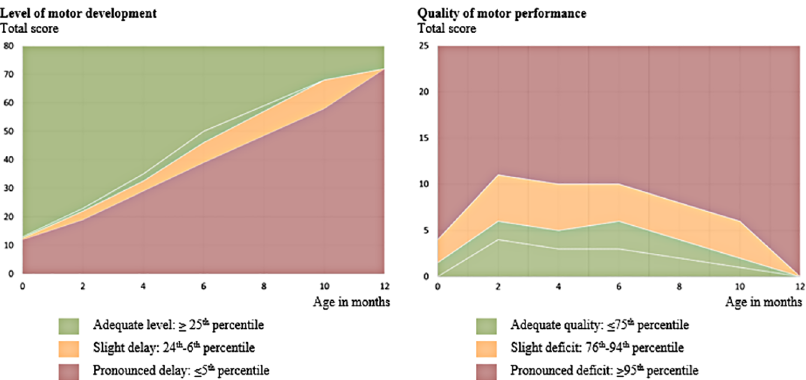
Fig 2. The percentile distribution of Structured Observation of Motor Performancein Infants. Total scores for level and quality are plotted at the infant’s age, corrected for prematurity when appropriate. The percentile distributionwas calculatedusing a reference group of neonatallyhealthyinfants assessed longitudinally using Structured Observation of Motor Performancein Infants (SOMP-I)[59]. The white line in the green area in both graphsrepresents the 50 th percentile.Reprintedfrom Persson K and JohansenK (2017) Structured Observation of Motor Performancein Infants [60] under a CC BY-NC-ND4.0 license, with permissionfrom Barnens ro¨relsebyr å Uppsalaek. fo¨r., originalcopyright2017.